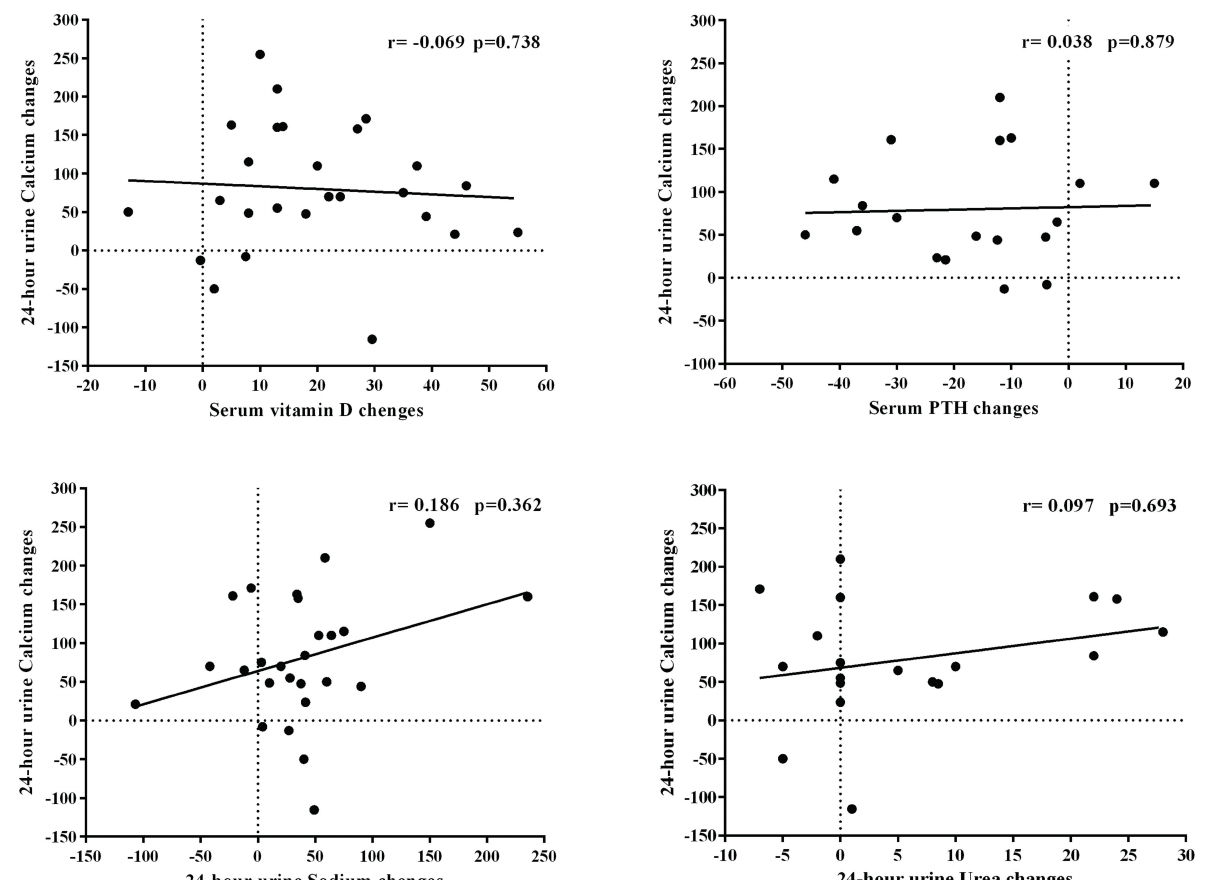
Figure 1 - The correlation between the changes in 24-hour urine calcium (24-h Ca) and the changes in serum 25 (OH) D, serum PTH, 24-hour urine sodium (24-h Na) and urea (24-h